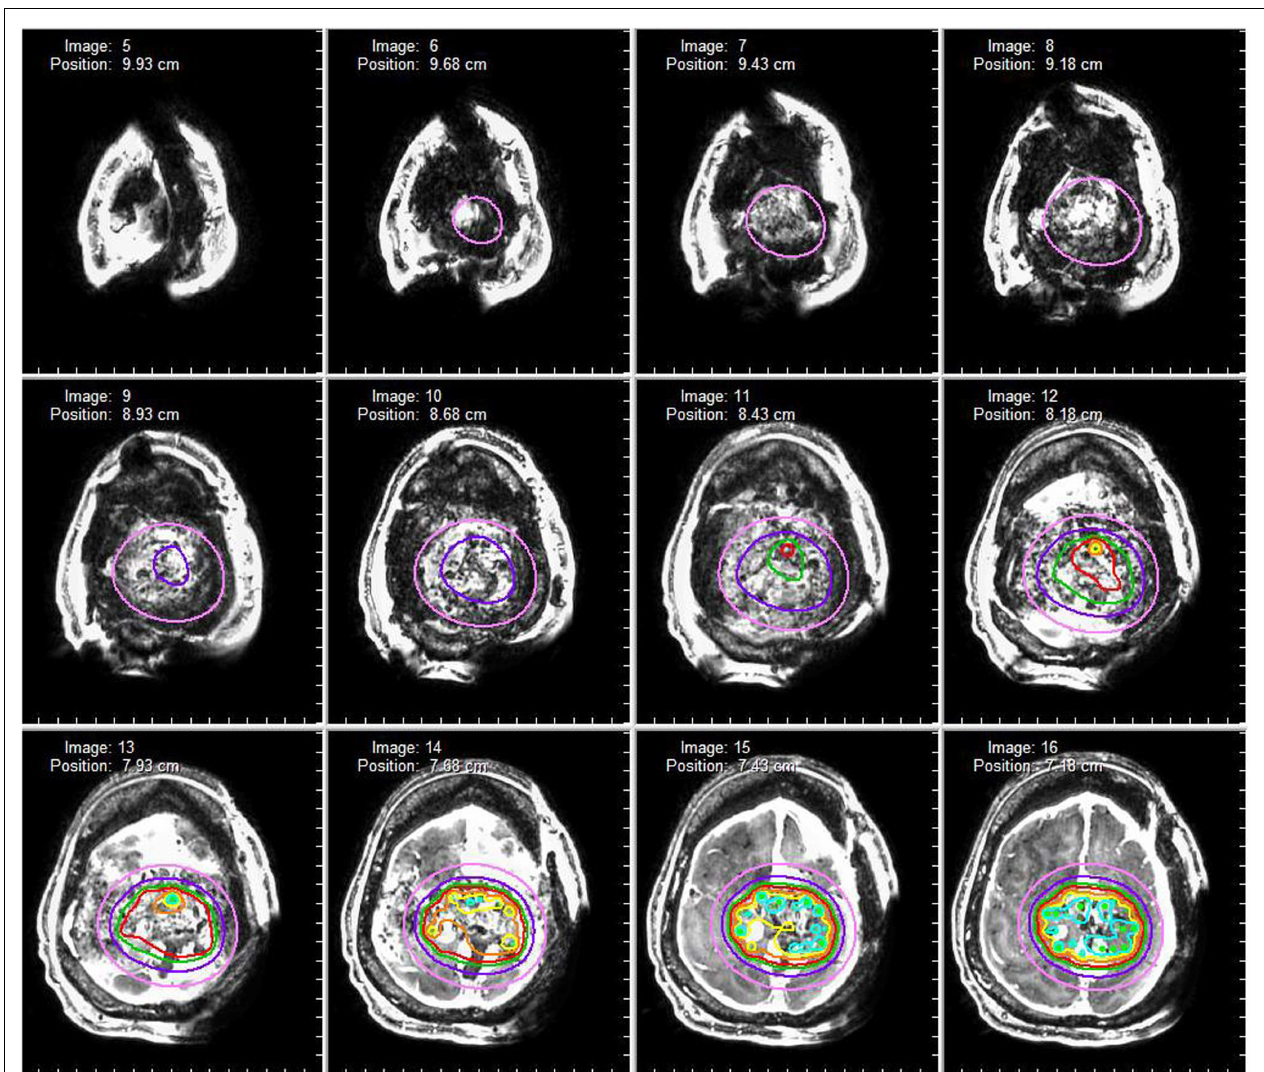
FIGURE 4 | Dosimetry map . A dosimetry map of the radioactive brachytherapy seeds is constructed based on seed arrangement in three-dimensional space. The red isodose line represents a prescription dose 80Gy (80% isodose level) whereas the pink isodose line represents a prescription dose of 25Gy (25%